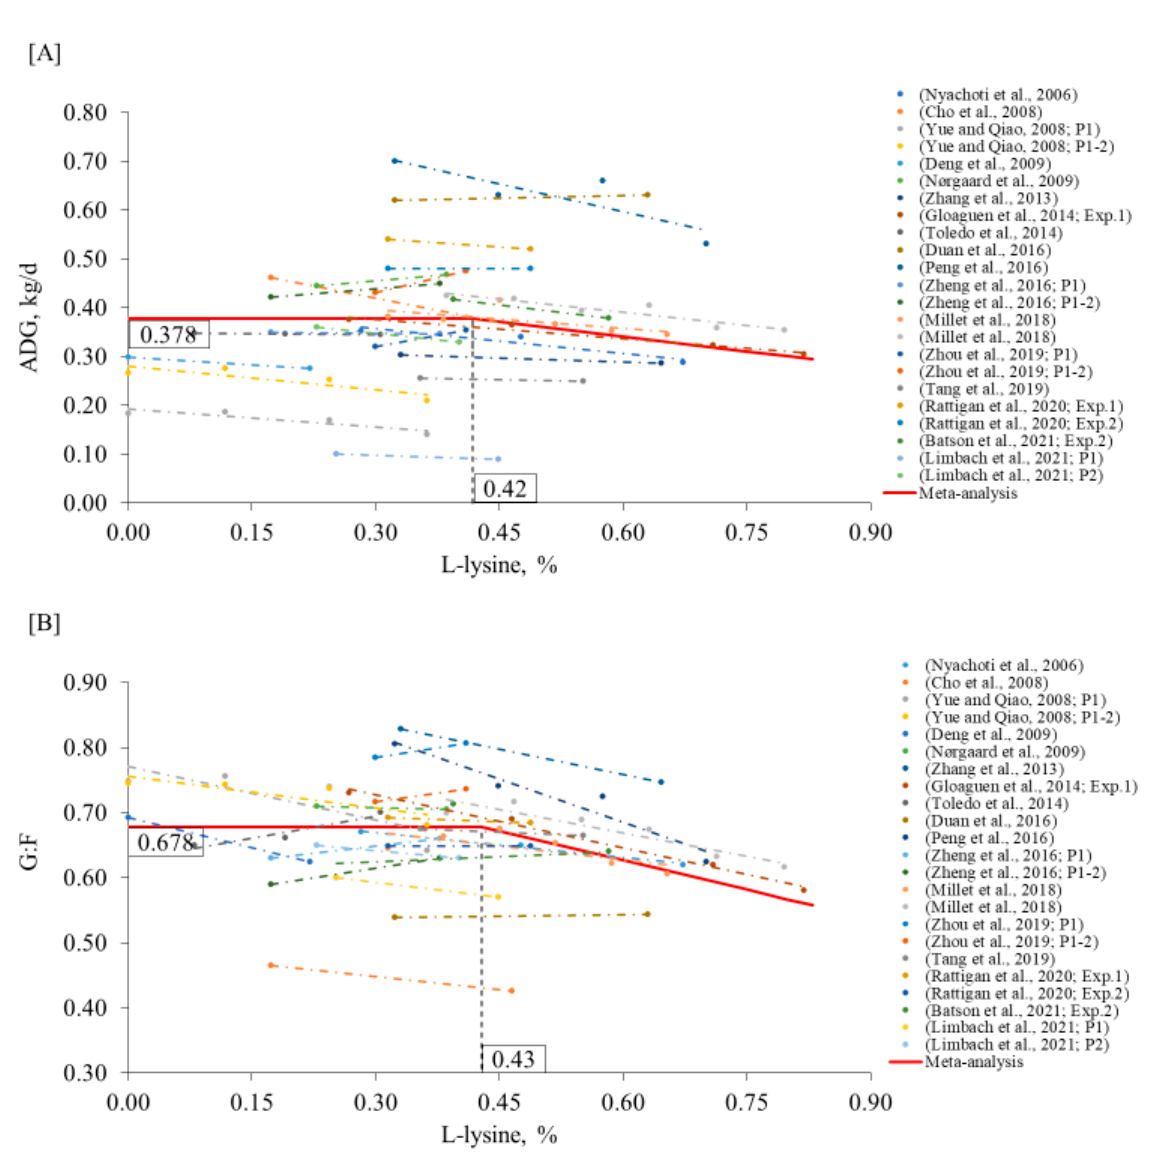
Figure 2. Changes in ADG ( A ) and G:F ( B ) in response to L-lysine supplementation in the nursery phase using a broken-line analysis. The L-lysine axis is based on 100% purity, calculated from L-lysine HCl (78.8% purity) or L-lysine sulfate (60.0% purity). The equation for ADG was ADG = 0.378 + 0.202 × zl (R 2 = 0.97) and the breakpoint was L-lysine level at 0.42% (95% CI: 0.30–0.53) when ADG was 0.378 kg/d. The p -value for the asymptote was <0.001, for the slope it was <0.001, and for the breaking point it